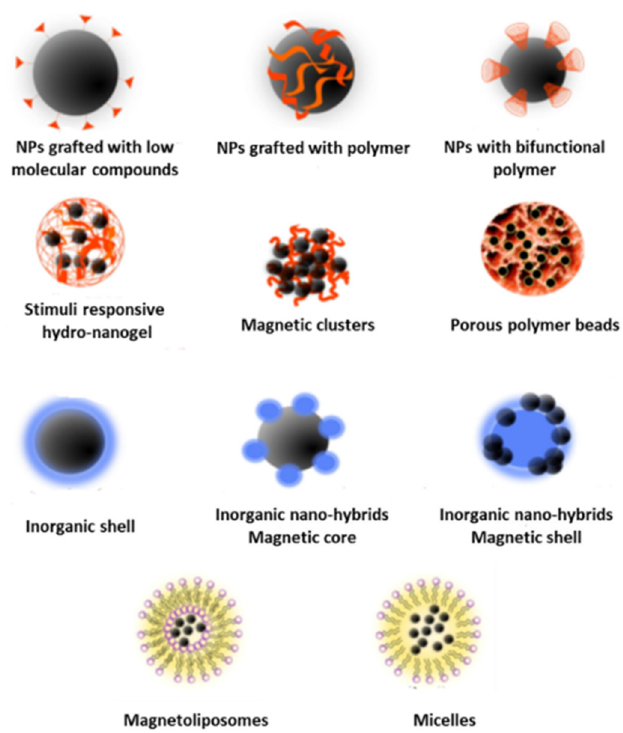
Figure 5. General types of magnetic nanoparticles arrangements with polymers, molecules, and inorganic nanoparticles